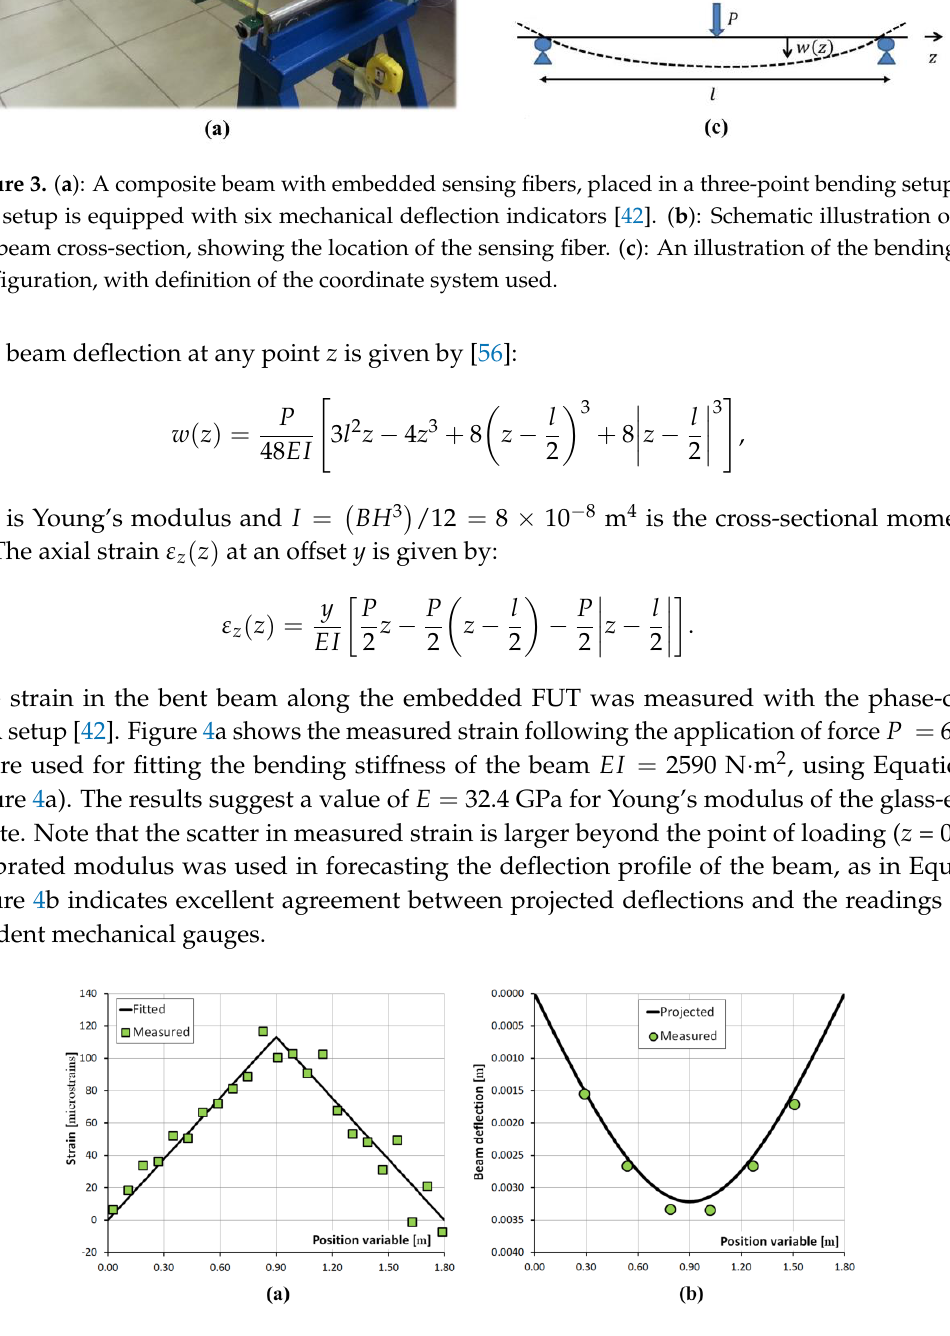
Figure 4. ( a ): B-OCDA strain measurements (squares), and computed strain after the calibration of bending stiffness (solid). ( b ): Independent point-measurements of beam deflection obtained with mechanical indicators (circles), and projected deflections based on the Brillouin analysis calibration of bending stiffness (solid) [42].